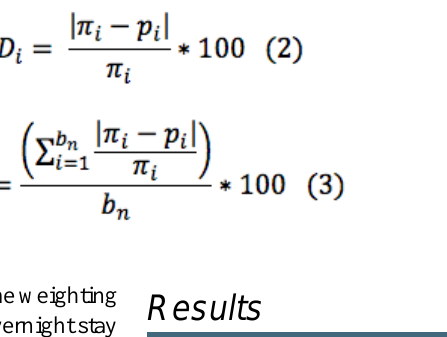
Figure 2. Absolute value of the relative difference and average relative difference